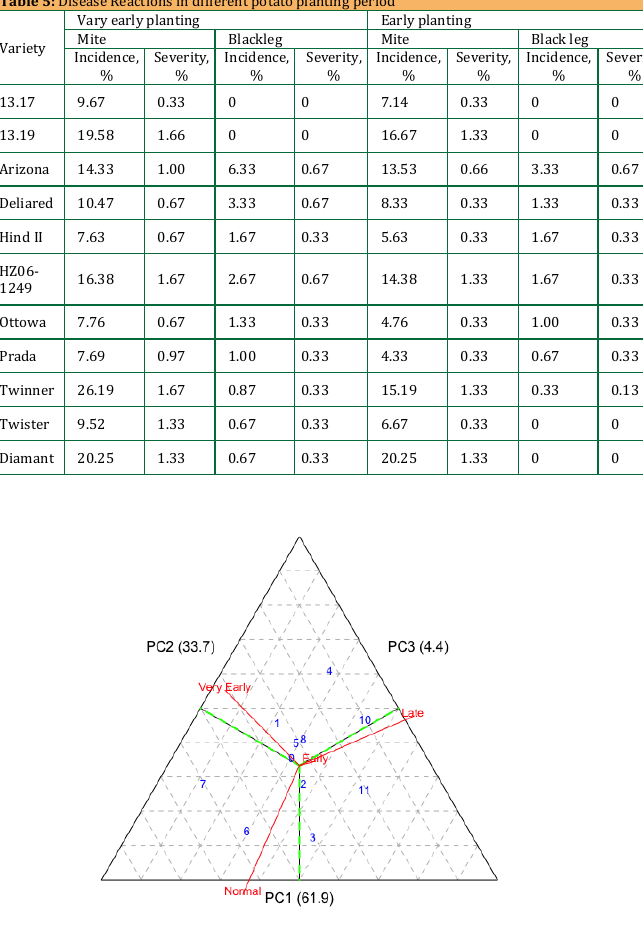
Table 5: Disease Reactions in different potato planting period Vary early planting Variety